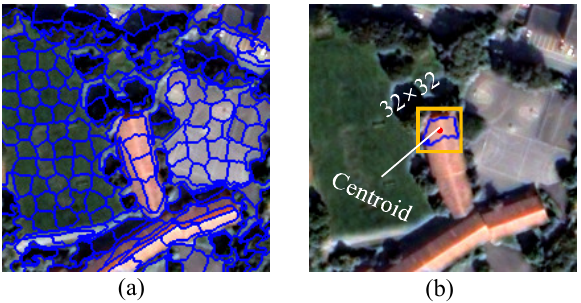
Figure 3. Intuitive description of the superpixel object cropping process. ( a ) Superpixel segmentation. ( b ) Cropping of image patches containing superpixel